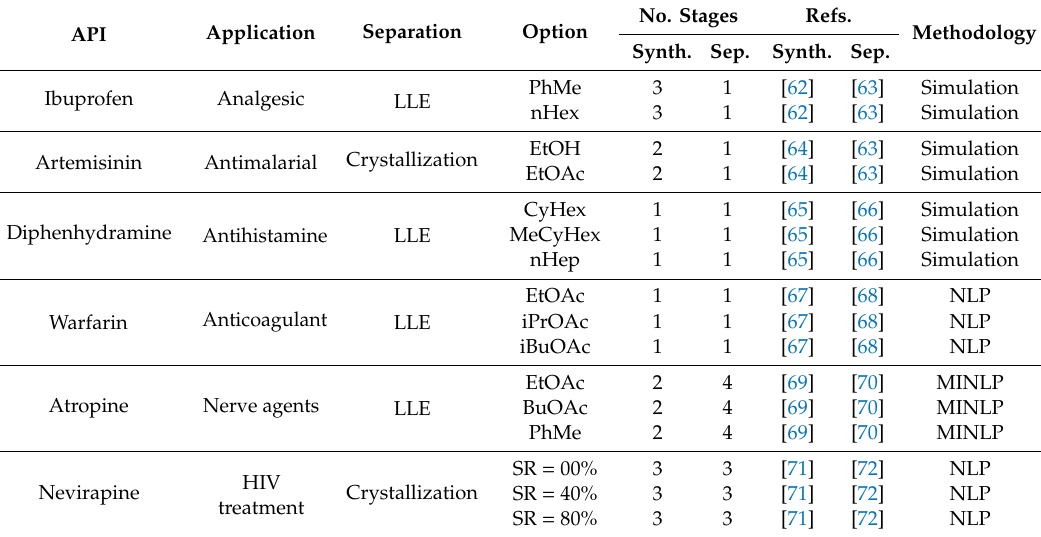
Table 1. Summary of separation design options for each API case study.